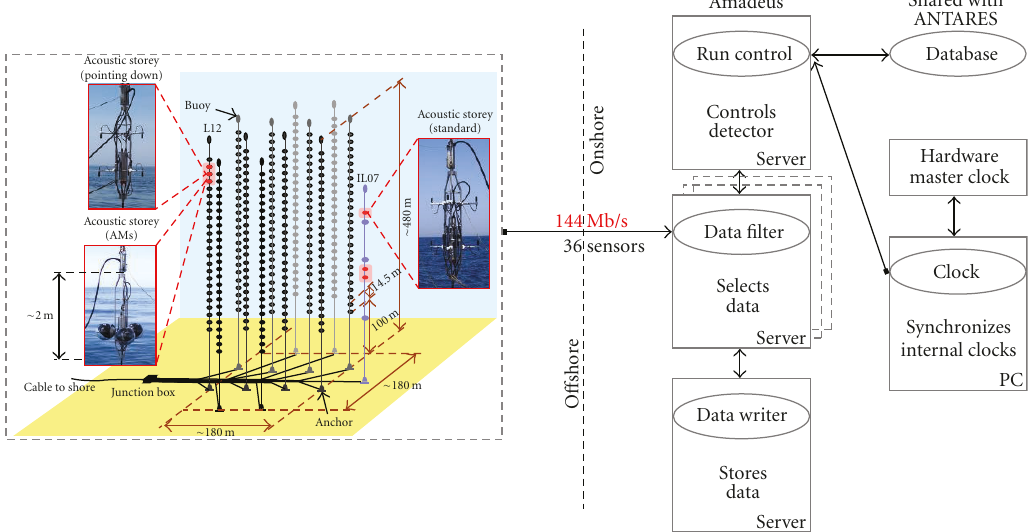
Figure 6: Overview of the AMADEUS DAQ system.